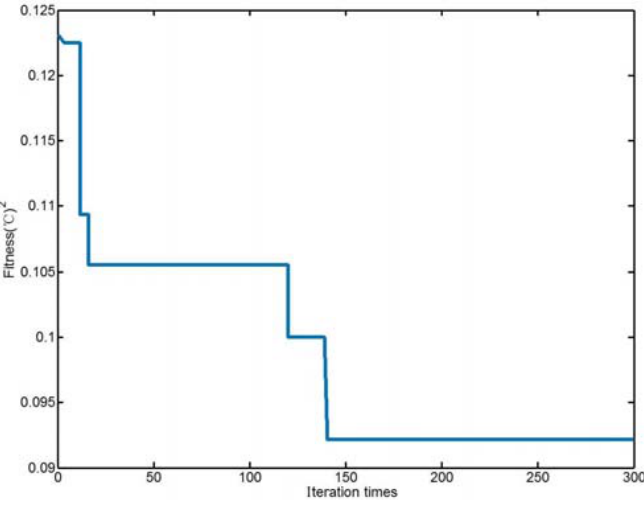
Figure 2. Particle swarm optimization (PSO) fitness curve.